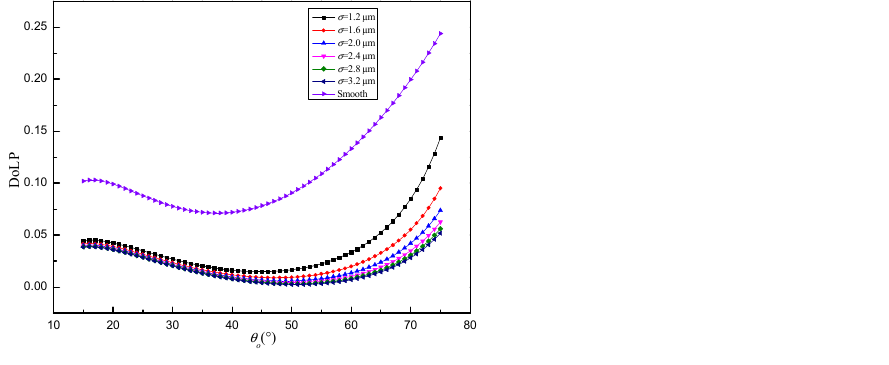
Figure 5. Variation of object’s DoLP with surface roughness at an object temperature of 48 °C.